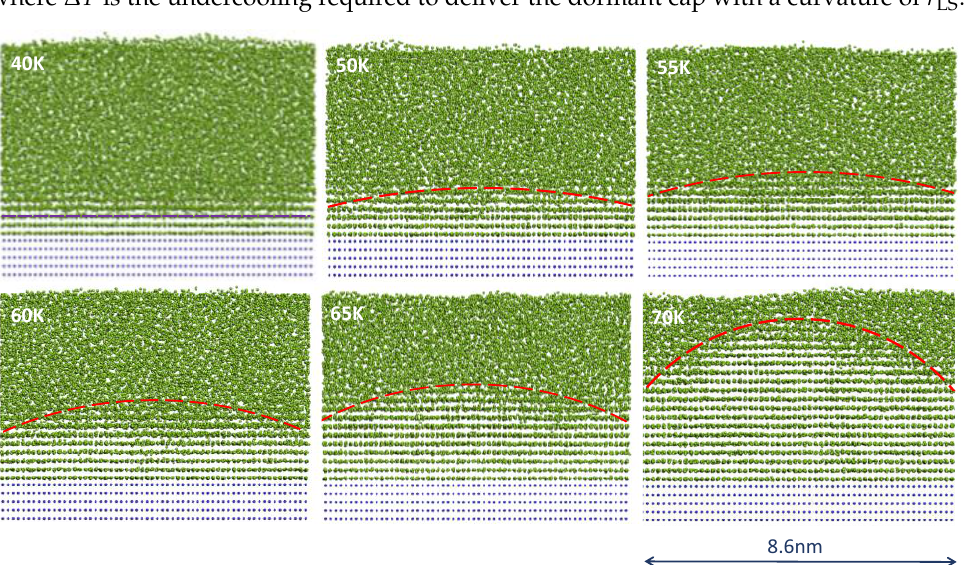
Figure 10. Time-averaged atomic positions of a simulation system with 2% lattice misfit showing the constrained cap formation process. After nucleation at ∆ T n = 40 K, further growth of the solid can only be made possible by increasing the undercooling. For this system, nucleation occurs at ∆ T n = 40 K (2 r n = 14.2 nm) on a substrate of 2 r N = 8.6 nm ( gi = 66 K), and the system was then subject to growth under increased undercooling that is marked by the data on each